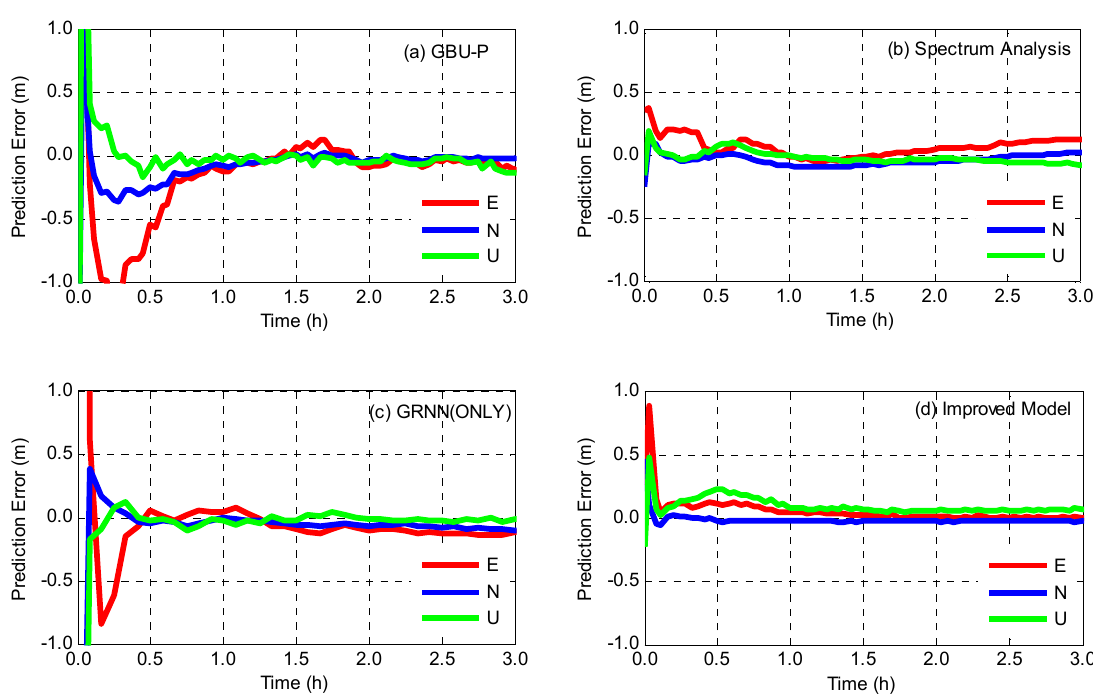
Figure 11. Position residuals of kinematic PPP for MRO1 station using ( a ) GBU-P, ( b ) spectrum analysis, ( c ) GRNN(ONLY) and ( d ) improved model, respectively.